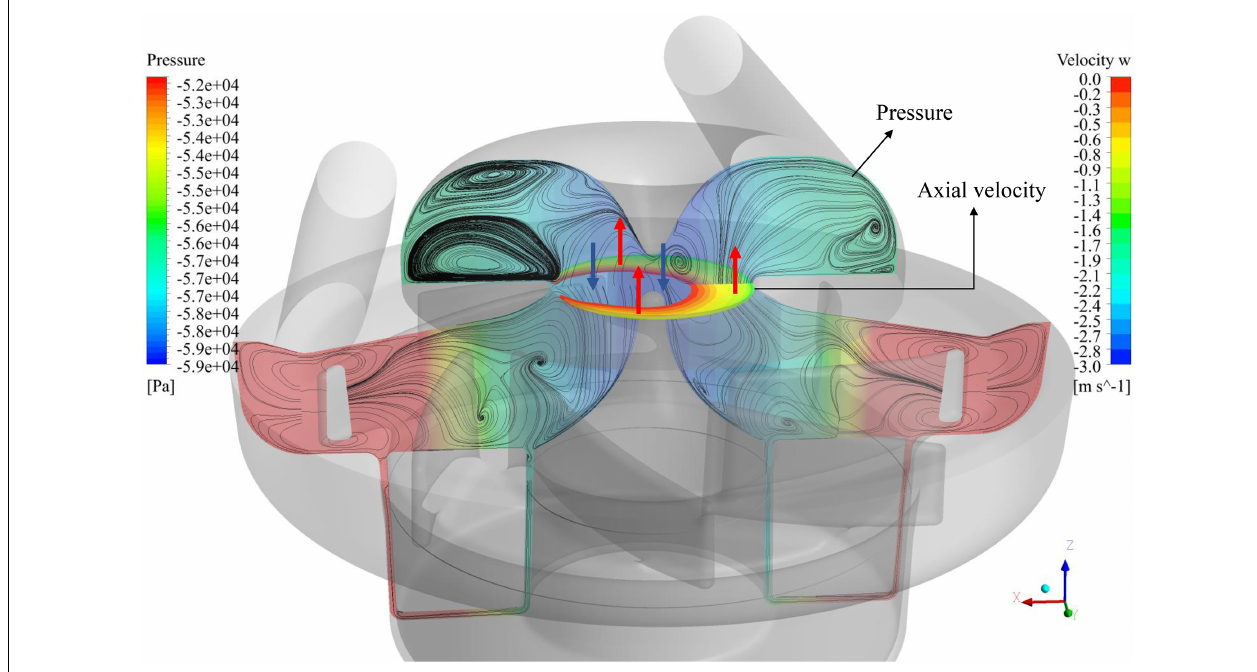
FIGURE 6 | Flow patterns at the meridional plane, where surface streamlines and pressure contours are shown. Positive axial velocity (backflow) contours at the cavity/impeller interface are also shown.